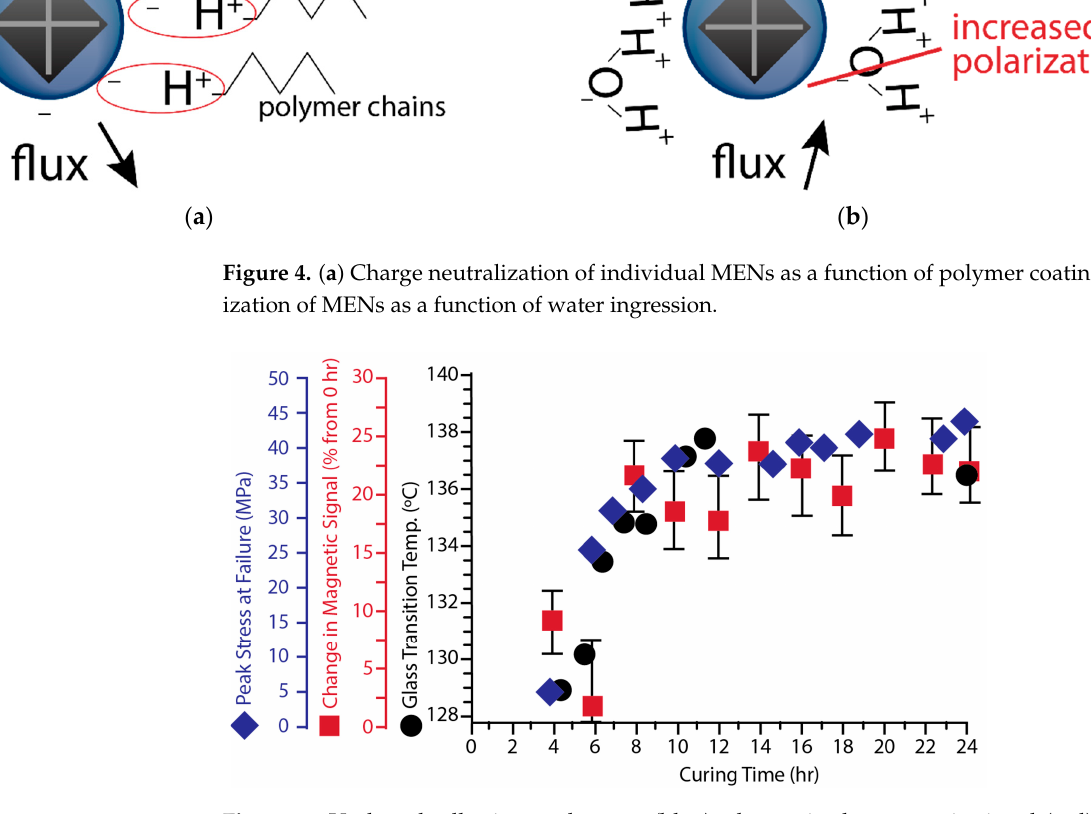
Figure 6. ( a ) Peak stress of undoped and doped adhesives for single lap shear samples; ( b ) load– displacement curves for undoped (black) and doped (red) samples. 3.4. End Notch Flexure (ENF) Regarding the ENF samples, Figure 7 shows the relationship between displacement and the mode II critical energy release rate G IIC at failure for each sample that was doped and undoped. The average G IIC value for each condition was 503 ± 46 J/m 2 and 564 ± 37 J/m 2 , respectively, showing an increase of 12% for the doped adhesive. The strengthening